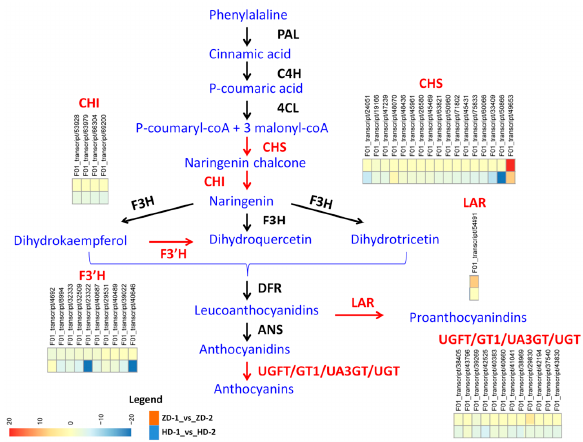
Figure 5. Flavonoid–anthocyanin biosynthetic genes in L. indica . The di ff erentially expressed genes between HD and ZD from Stage 1 (young leaves) to Stage 2 (mature leaves) are highlighted in red color. Phenylalanine ammonia-lyase (PAL), cinnamic acid 4-hydroxylase (C4H), 4 coumarate CoA ligase (4CL), chalcone synthase (CHS), chalcone isomerase (CHI), flavanone 3-hydroxylase (F3H), flavonoid 3’-monooxygenase (F3 (cid:48) H), dihydroflavonol 4-reductase (DFR), by anthocyanidin synthase (ANS), leucoanthocyanidin reductase (LAR), UDP-flavonoid glucosyl transferase (UFGT), anthocyanidin 3-O-glucosyltransferase (UA3GT), anthocyanidin 5,3-O-glucosyltransferase (GT1), and anthocyanidin 3-O-glucoside 2 (cid:48)(cid:48)(cid:48) -O-xylosyltransferase (UGT). The heatmap show the log2 fold change of the gene expression from Stage 1 to Stage 2. HD represents the cultivar Lagerstroemia Dynamite, while ZD represents the cultivar Lagerstroemia Ebony